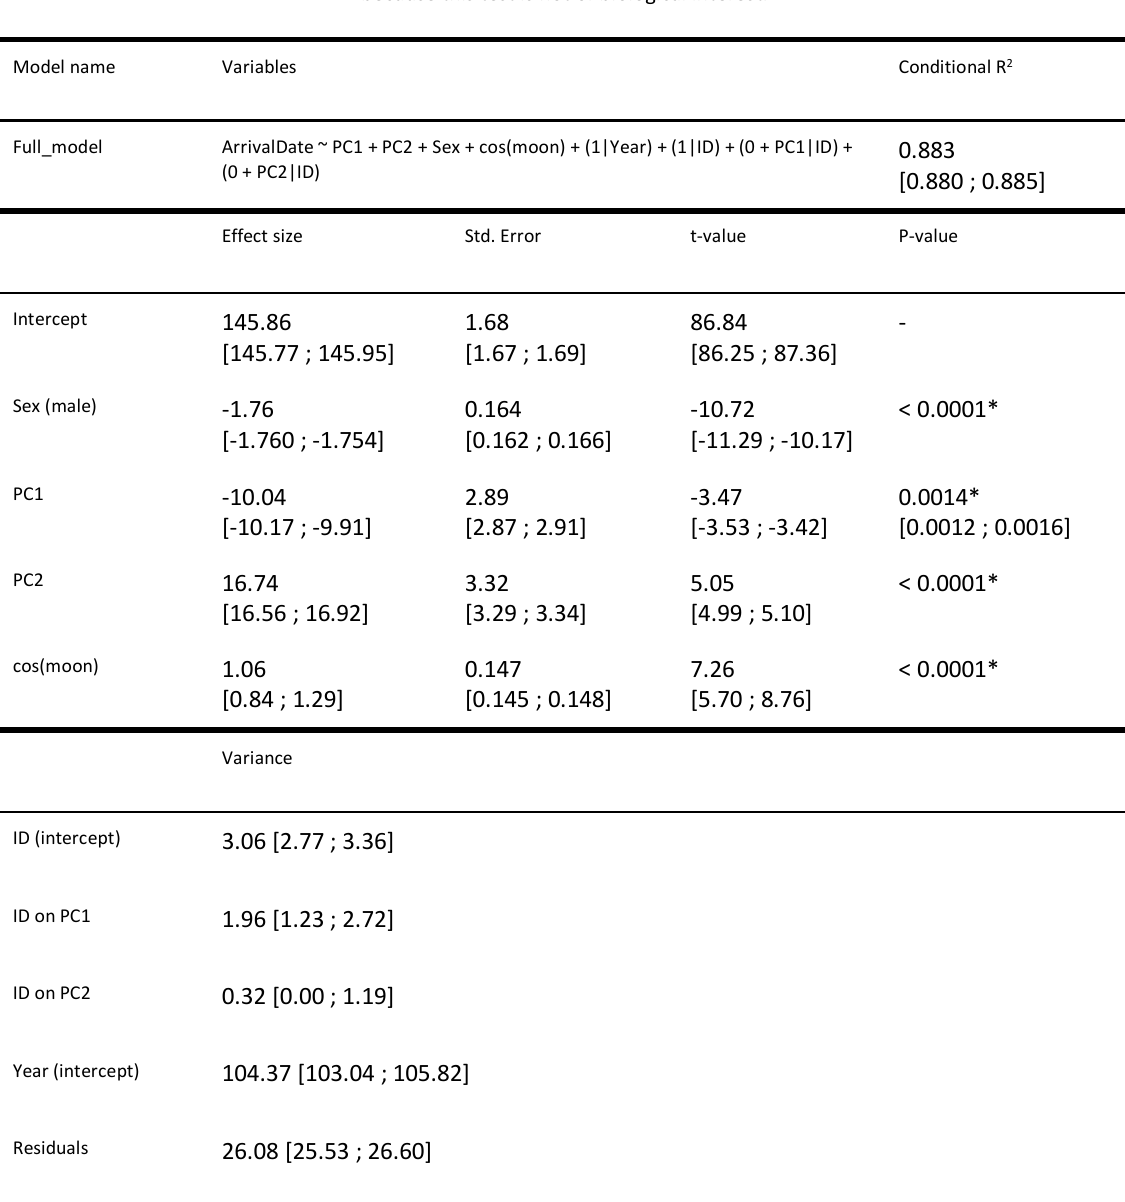
Table S3. Detailed description of the model used to check for the effect of environmental variables on the phenology at the individual level. Sex is included to observe differences between males and females. The response variable ArrivalDate is a vector of dates of arrival at the breeding site for each individual over the study period. PC1 and PC2 are the first two components of the PCA performed on the climatic data. Cos(moon) is the cosine of the lunar angle for the arrival date. ID refers to the identity of each individual, and it is used as a random effect on both intercept and the slopes of PC1 and PC2. Finally, Year is included as a random effect to account for additional unexplained variation that might be caused by sampling variation. The second and third part of the table provide details on the estimates for the fixed and random effects respectively. The values shown are the mean value out of the 1000 models ran on simulated datasets and in square brackets we show the 2.5 th and the 97.5 th percentiles of each parameter. No p-values are provided for the intercept because this test is not of biological